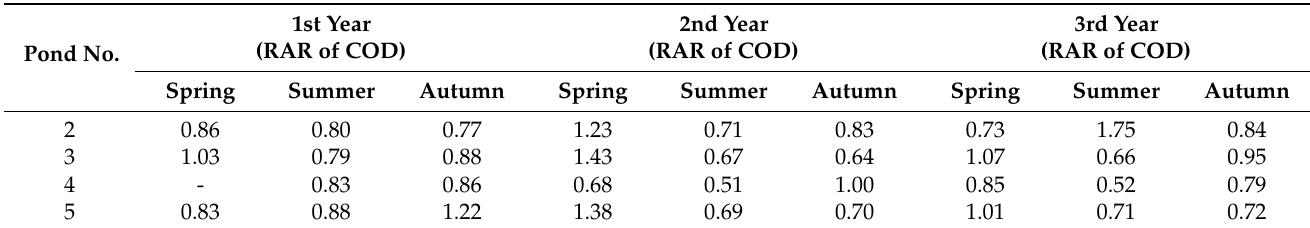
Table 9. Statistics of the RAR 1 of the quarterly average COD value at each pond.